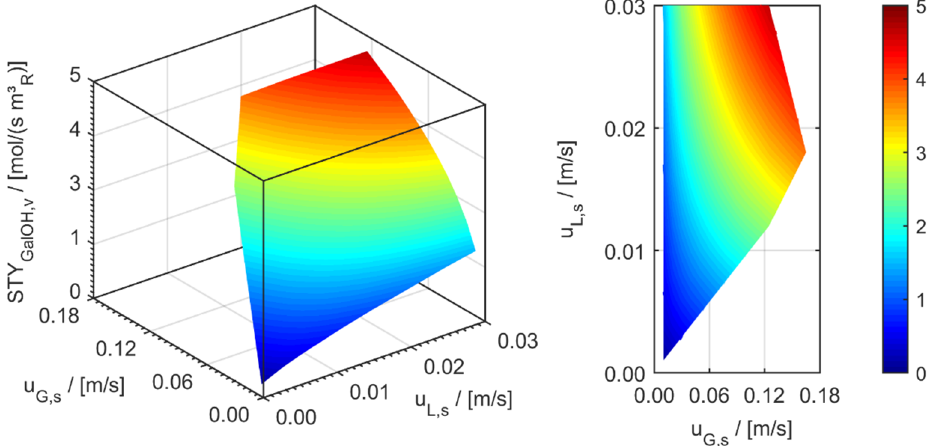
Figure 22. Volumetric space-time yield referring to galactitol in trickle-bed reactors operating at different gas and liquid superficial velocities.